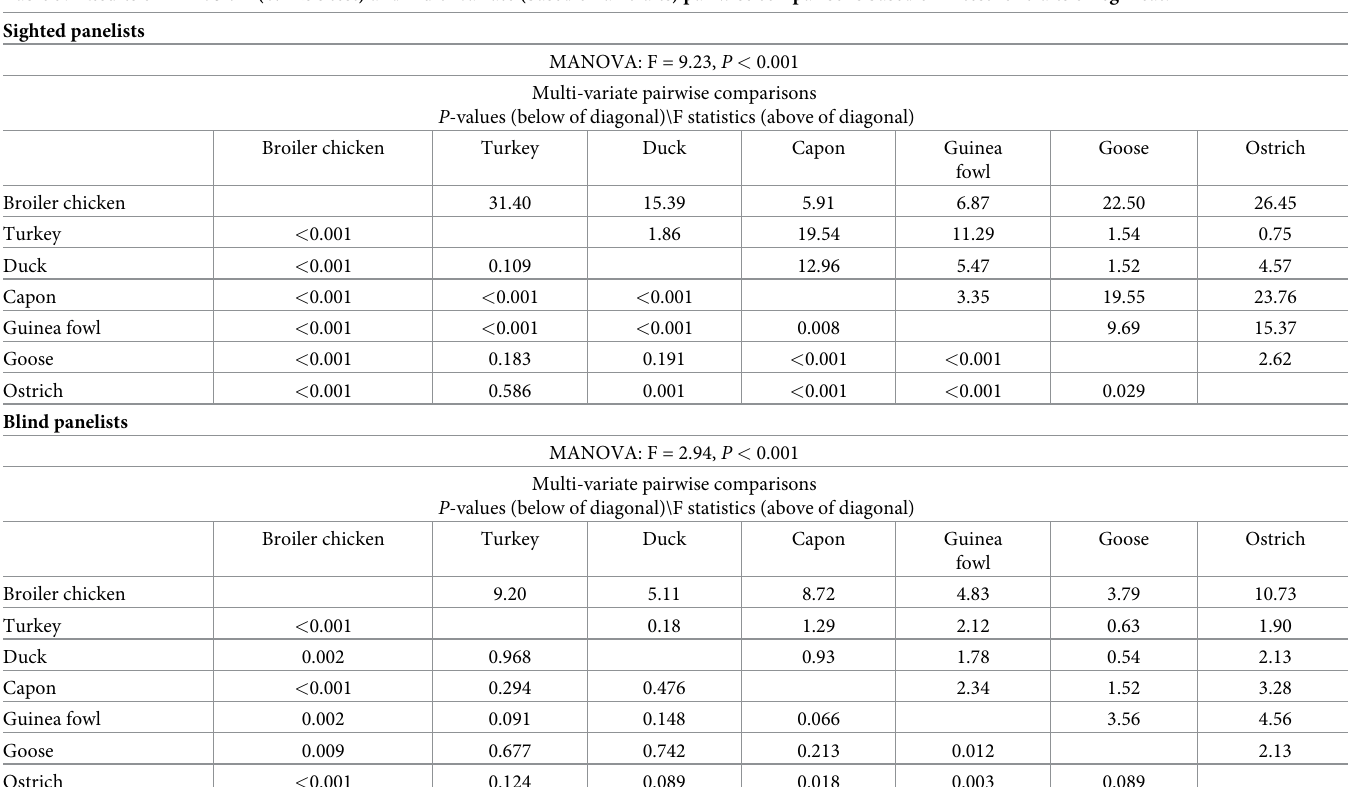
Table 3. Results of MANOVA (Wilks’s test) and multi-variate (based on all traits) pairwise comparisons based on F-test for traits of leg meat. Sighted panelists